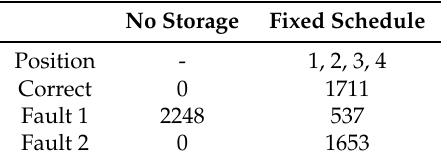
Table 7. Results for the scenario without storage and the fixed schedule.